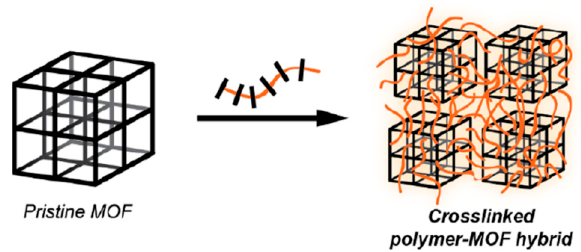
Figure 10. Schematic of direct integration through post-synthetic ligand exchange to form a crosslinked polymer-MOF network with preserved porosity [109].